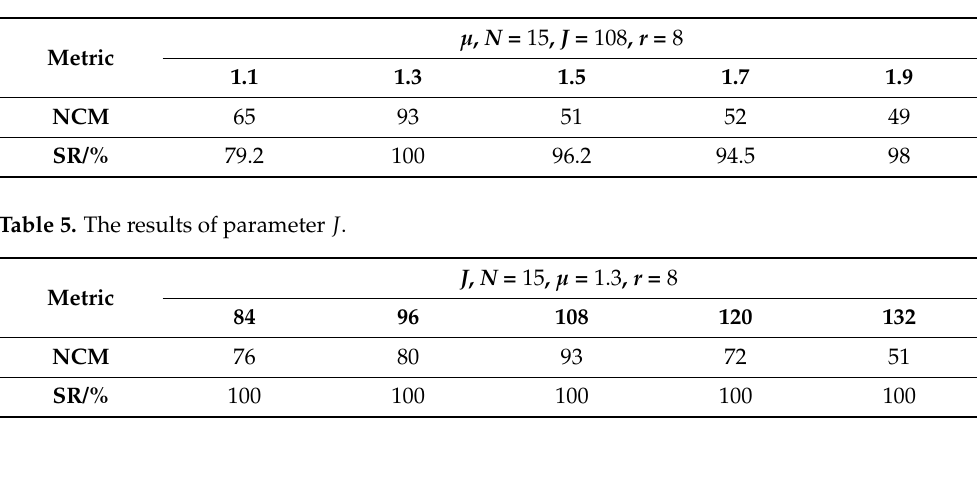
Table 4. The results of parameter µ .